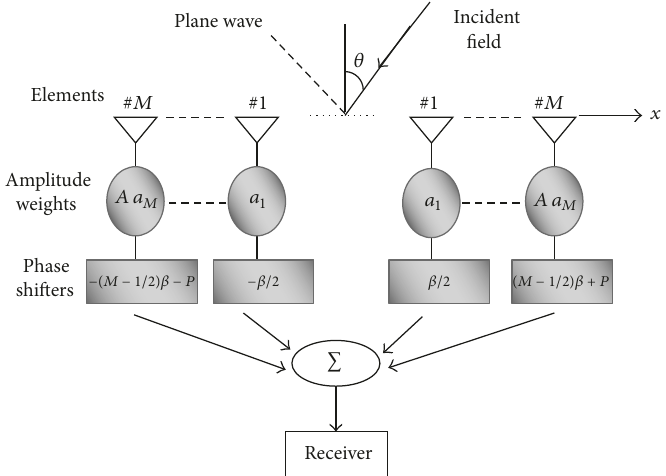
Figure 1: Block diagram of the proposed